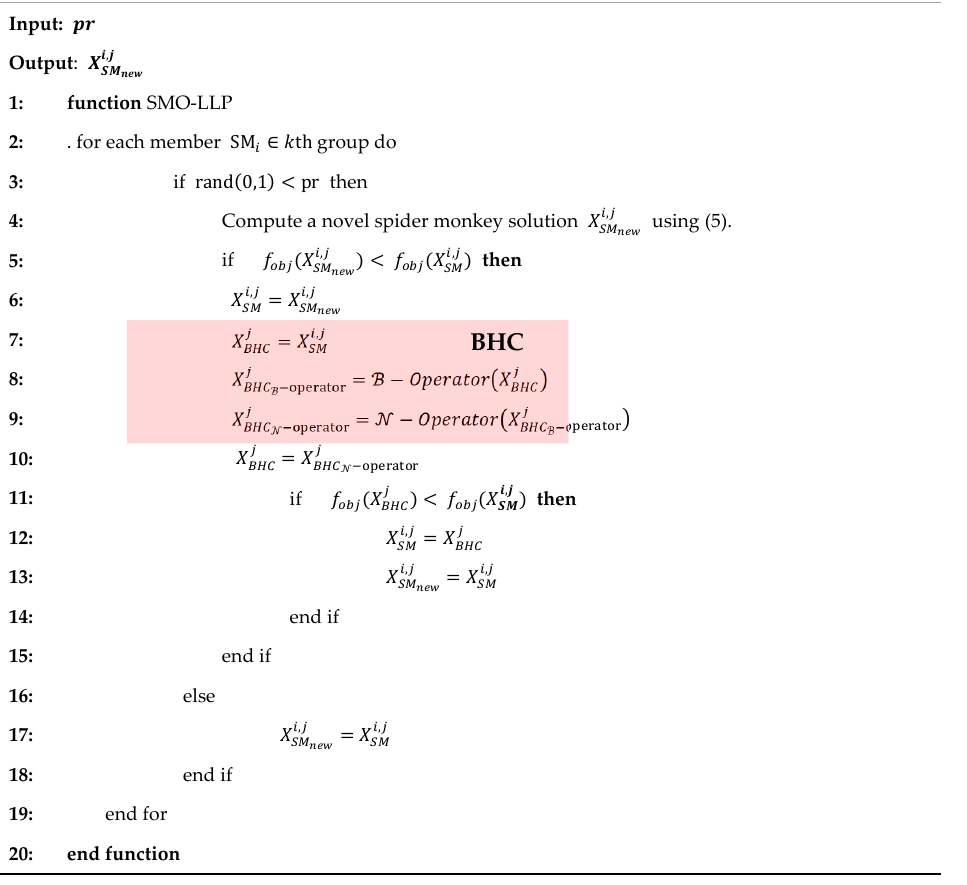
Algorithm 5 : Local Leader Phase (LLP) based on BHC